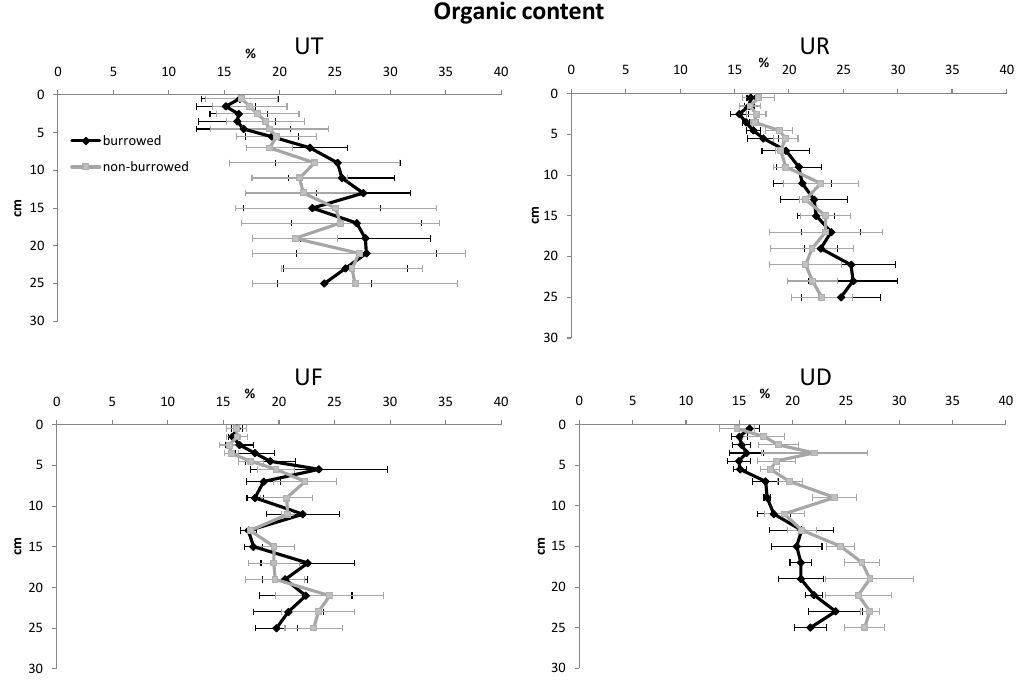
Figure 4. Vertical distribution of organic content in burrowed and non-burrowed sediments of U. triangularis (UT), U. rosea (UR), U. forcipata (UF) and U. paradussumieri (UD) habitat. No significant differences were detected by ANOVA between burrowed and non-burrowed plots for water and OM, once all sampled depths were considered (Table 1). Analysis of variance indicated that all sediment properties varied significantly with depth ( p < 0.01). All environmental variables except the iron pools Fe (II) and Fe (III) differed significantly among habitats ( p < 0.01). and non-burrowed mudflats ( p < 0.01).